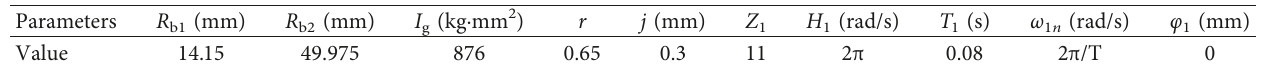
Figure 3: The fluctuation of angular velocity and angular acceleration. Table 1: Parameter value under the first gear